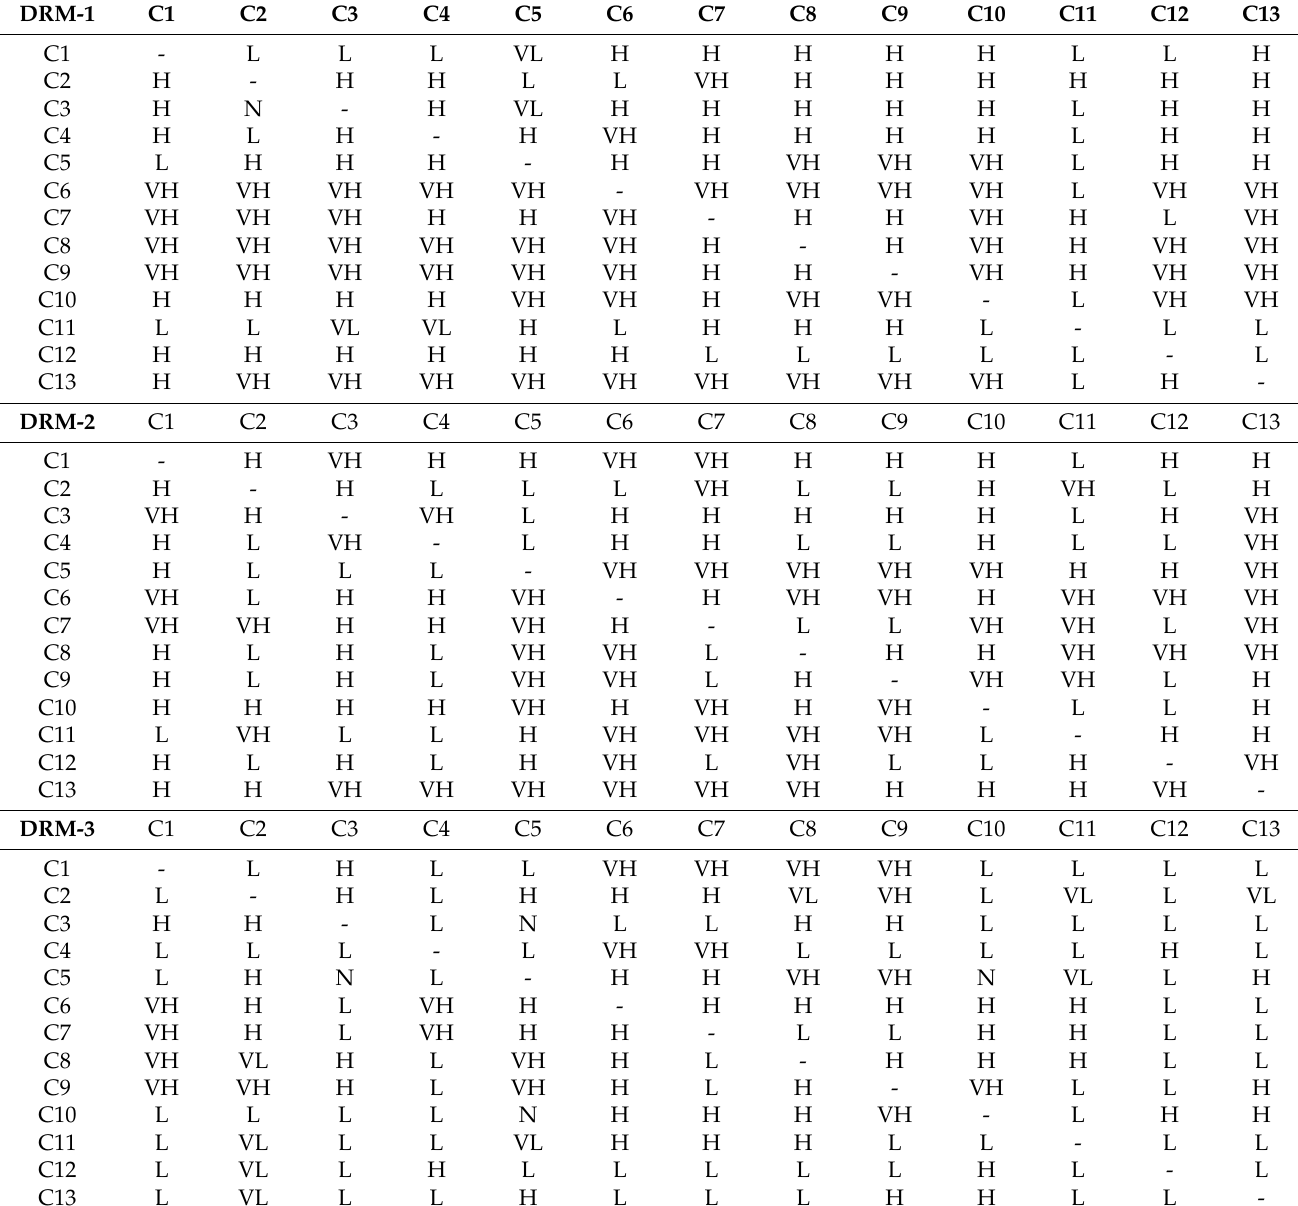
Table 2. Criteria relation data obtained from the